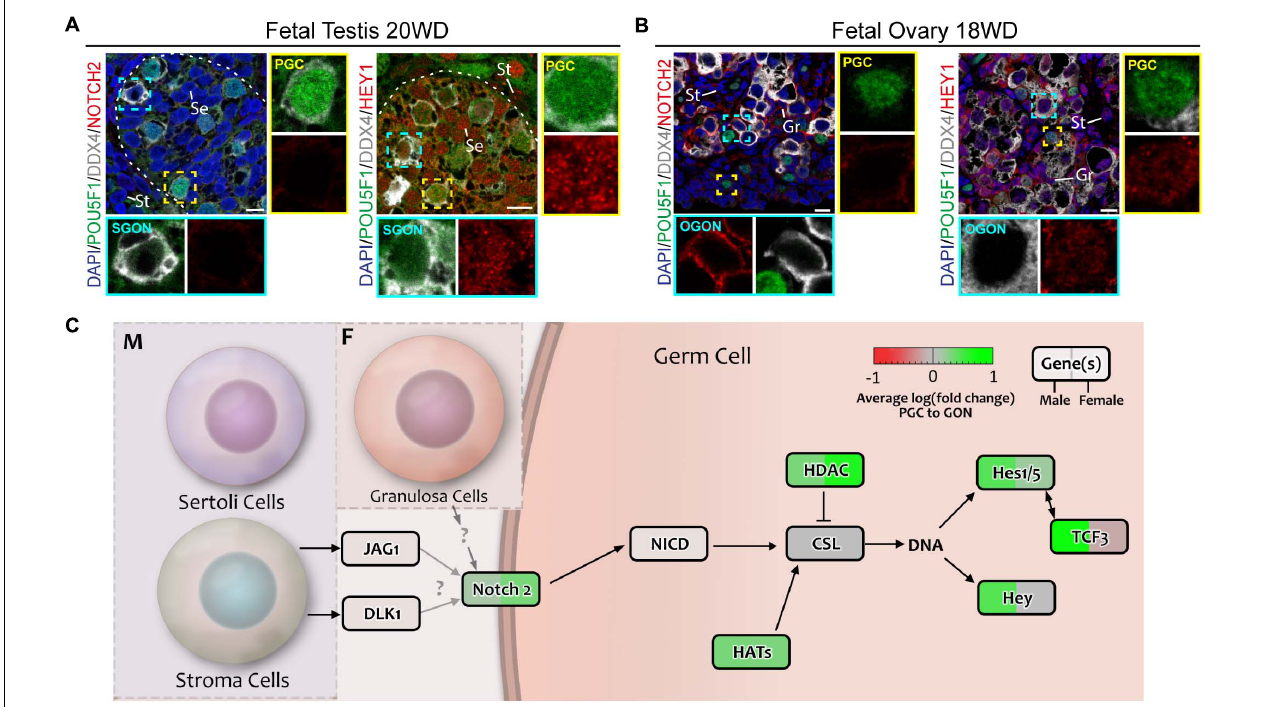
FIGURE 10 | Analysis of NOTCH signaling in fetal gonads by immunostaining for NOTCH2 receptor and downstream effector HEY1. (A,B) Immunofluorescence of NOTCH2 and HEY1 with DDX4 and POU5F1 in fetal testis of 20 weeks development (WD) (A) and fetal ovary of 18 WD (B) . NOTCH2 is absent in the testis, but is highly expressed in female germ cells. HEY1 is present in most cell types of the testis and ovary, suggesting general activation of the NOTCH pathway. Yellow boxes indicate zoom-in of a PGC, and cyan boxes indicate zoom-in of a GON. Se, St, and Gr annotate Sertoli, stromal, and granulosa cells, respectively. Scale bar indicates 10 µ m. (C) A schematic model of active signaling NOTCH axes in germ cells representing a combination of results from CellphoneDB analysis and differentially expressed gene analysis. Genes upregulated in GONs are depicted in green, while those upregulated in PGCs are depicted in